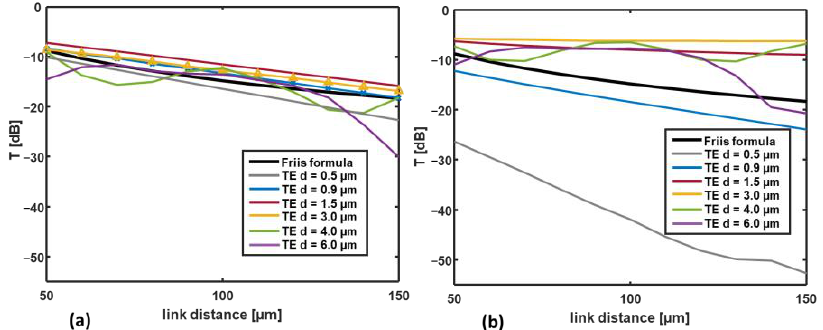
Figure 9. Transmittance in dB, which is calculated at the receiver waveguide as a function of the link distance for different values of the PMMA top-layer thickness: ( a ) TE and ( b ) TM polarizations. The black curves denote the transmittance calculated by the Friis transmission equation for a point- to-point link in a homogeneous medium (with refractive index n SiO2 = 1.445). The wavelength is λ = 1.55 µ